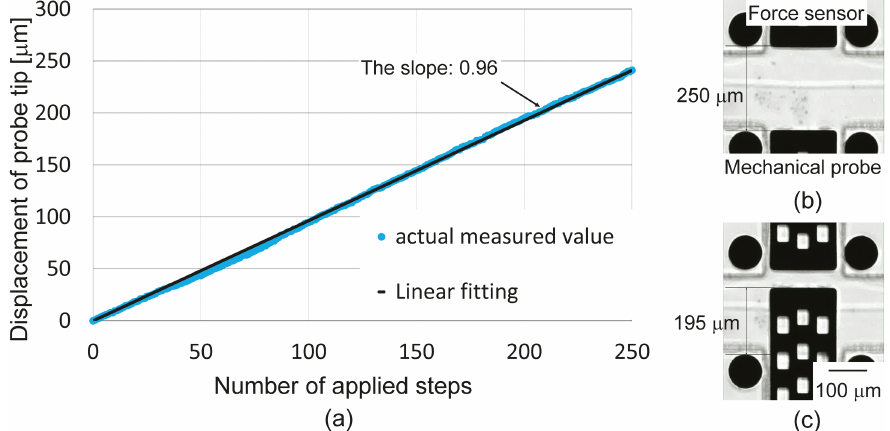
Figure 7. Performance evaluation of mechanical probe: ( a ) Displacement of probe tip vs . step count; ( b ) original probe position; ( c ) position after 200 steps of the stepping